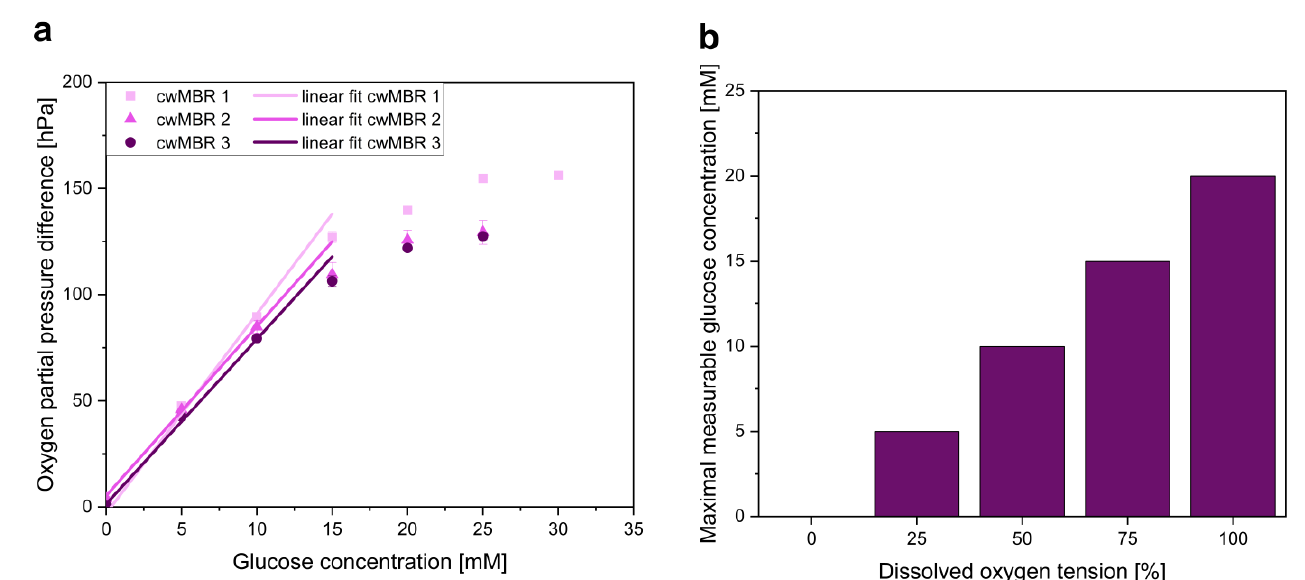
Figure 4. ( a ) Oxygen partial pressure difference (∆ p O2 ) between oxygen and glucose sensors in the cwMBR with linear fit. Glucose solutions between 0 and 30 mM in M9 minimal medium were used. The results indicate proportionality between ∆ p O2 and the glucose concentration within the dynamic range; ( b ) maximal measurable glucose concentration of the sensor at dissolved oxygen tensions between 0 and 100%. The results illustrate an increasing dynamic range with rising oxygen availa- bility.